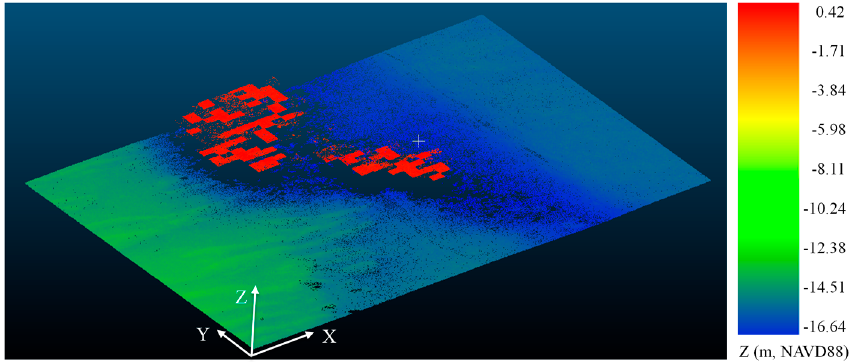
Figure 10. An example of the seafloor points segmented from the Virginia Key area, representing an over-segmentation issue due to the missing seafloor